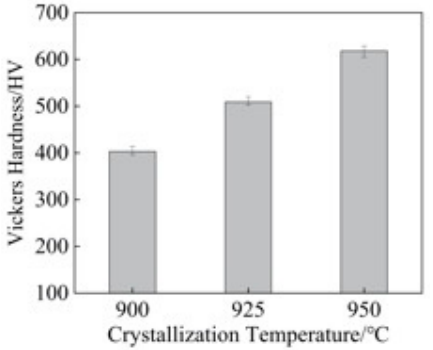
Figure 8. Effects of crystallization temperature on the Vickers hardness of the microcrystalline glass.